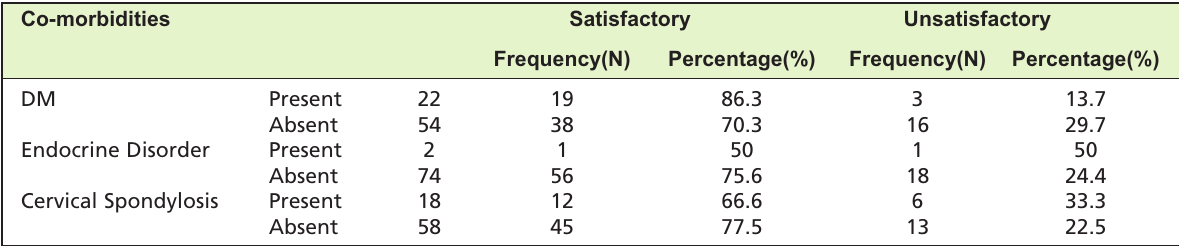
Effectiveness of CTR surgery in the presence of Table IV: